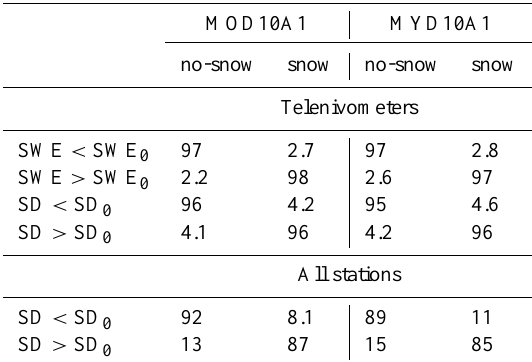
Table 2. Confusion matrices between the MODIS snow products and in situ data. The numbers correspond to percentages with re- spect to the number of in situ measurements. The comparison was performed both for snow water equivalent (SWE) and snow depth (SD) measurements. The detection thresholds were set to SWE 0 = 40mmw . e . for SWE and SD 0 = 150mm for SD. These thresholds yielded the best κ coefficients. MOD10A1 MYD10A1 no-snow snow no-snow snow Telenivometers